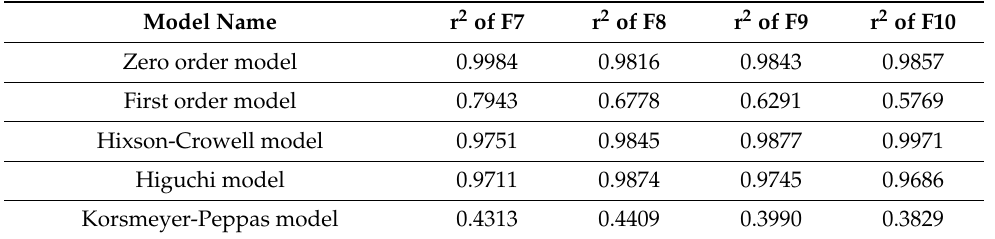
Table 3. Mechanism of DLZ release from controlled release polymer matrices using various kinetic release models represented by r 2 .